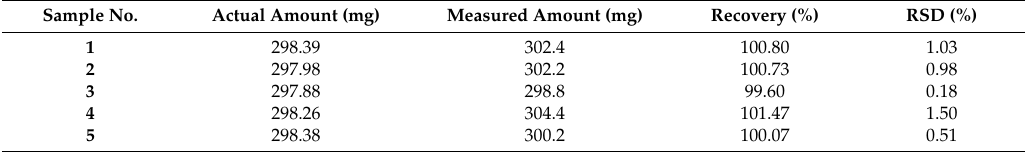
Table 2. Rifampicin assays and the determination of recovery percentage using CNDs (n = 5). Sample No.